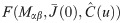
(A) Plot of F(Mαβ,J¯(0),C^(u)) (with α, β ∈ {a, b, c}) where J(0) is sparse and homogeneous (see C) and C^(u) is as in Fig 8. Colors represent the pair of pre- and post-synaptic groups αβ as in the upper left key. (B) Plot of F(Mba,J¯ba(t),C^(u)) as J¯(t) evolves over time indicated by the color scheme. Curved arrows illustrate the iteration scheme J¯ba(t+T)=J¯ba(t)+Fba(J¯(t),J¯(t),C^) and culminate at the equilibrium Jba*. (C) Middle: evolution of synaptic weights over time, color-coded as in A. Thick solid lines show analytical predictions of order 4, thick dotted lines show averages from simulations and thin lines show examples of individual synapses Jij(t). On either sides: plots of J¯(t) and J(t) used for simulations for t = 0 (left) and t = 80 hours (right). (D) Scatter plot of J¯αβ(t) and corresponding averages of simulated J(t) over all time points plotted in C. For both C and D, N = 60, p = 0.3, Jmin = 0, Jmax = 0.1, η = 10−8 and Jij(0) = Jmax/4.